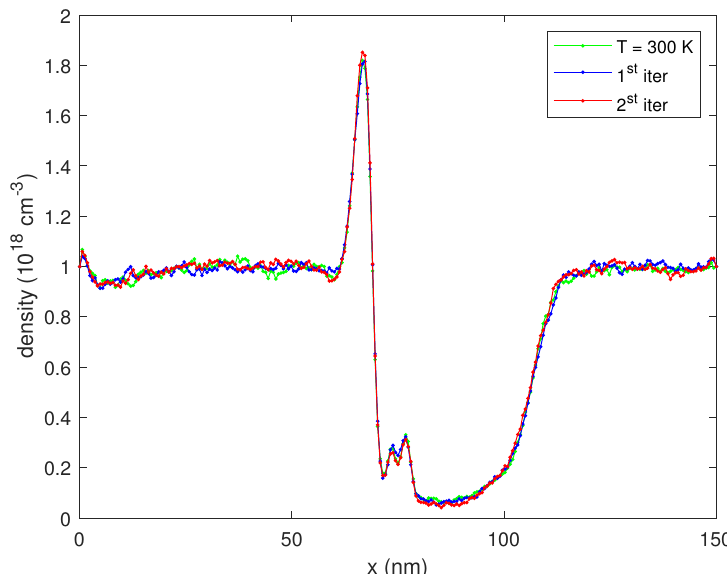
Figure 5. The density versus position for some iterations, for V b = 0.8 V.